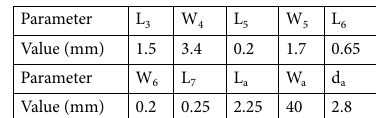
Table 3. Parameter values of the integrated phased array.